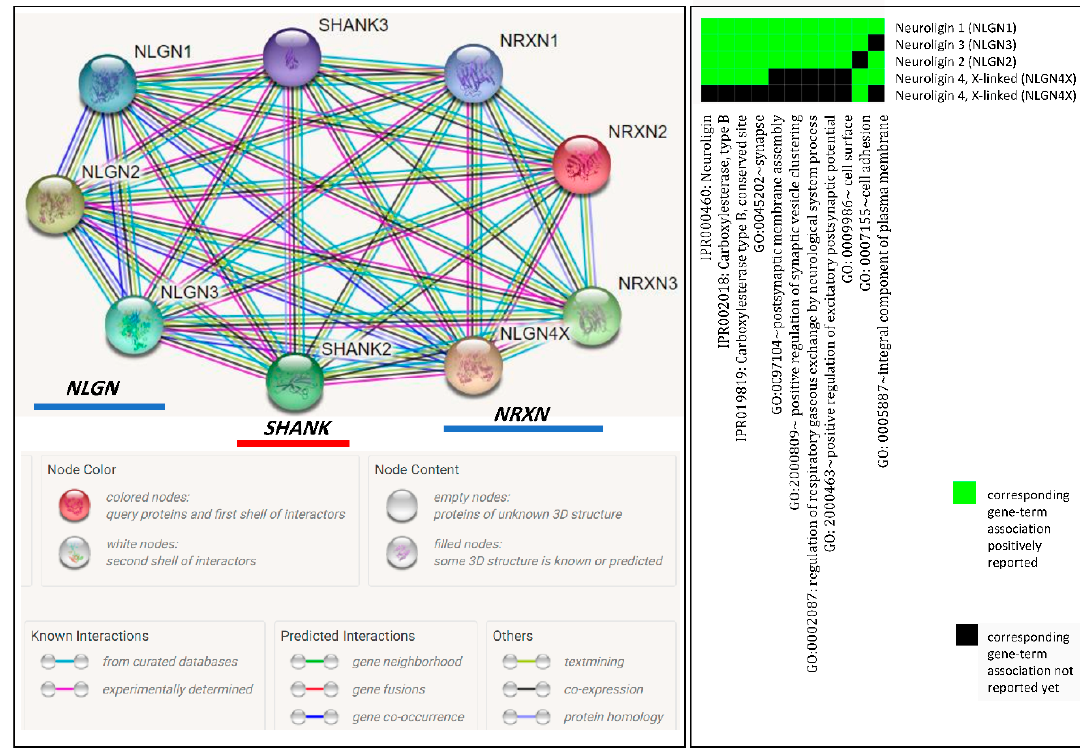
Figure 1. ( Left ) STRING results of protein–protein interactions between NLGN , SHANK , and NRXN synaptic genes. ( Right ) Functional annotation clustering from DAVID.